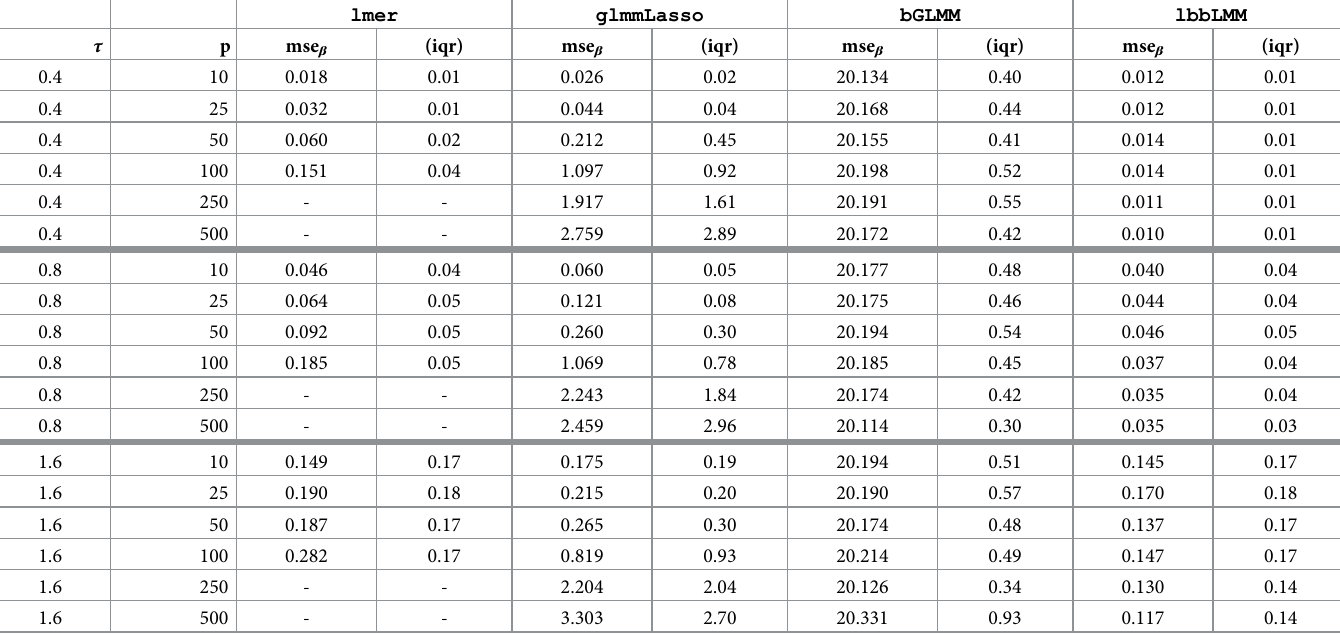
Table 1. Median mse β of 100 independent simulation runs for each random intercepts setup with corresponding interquartile range.